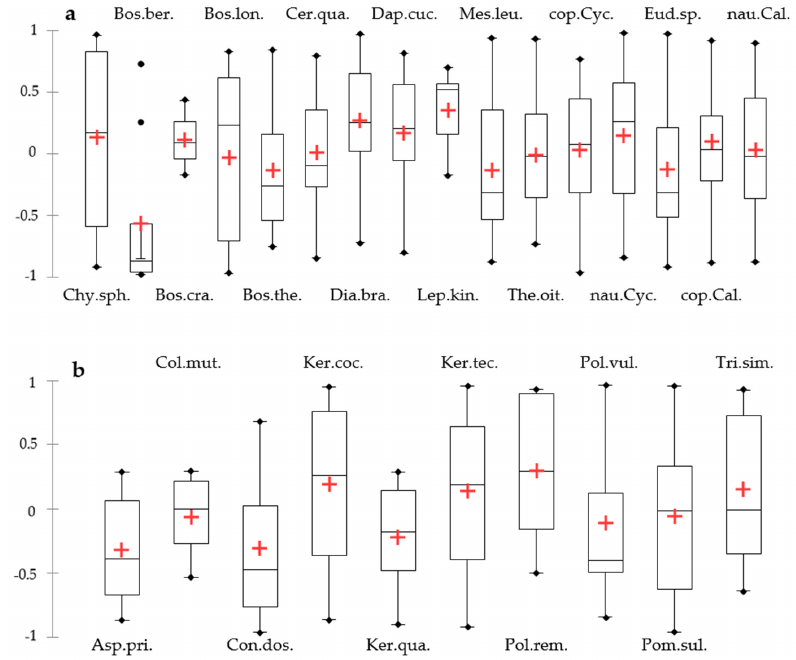
Figure 8. Habitat Preference Index (HPI) to the anoxic/oxic water layer for selected Crustacea ( a ) and Rotifera species ( b ). Positive values mean preference for oxic layer, while negative values means preference for anoxic